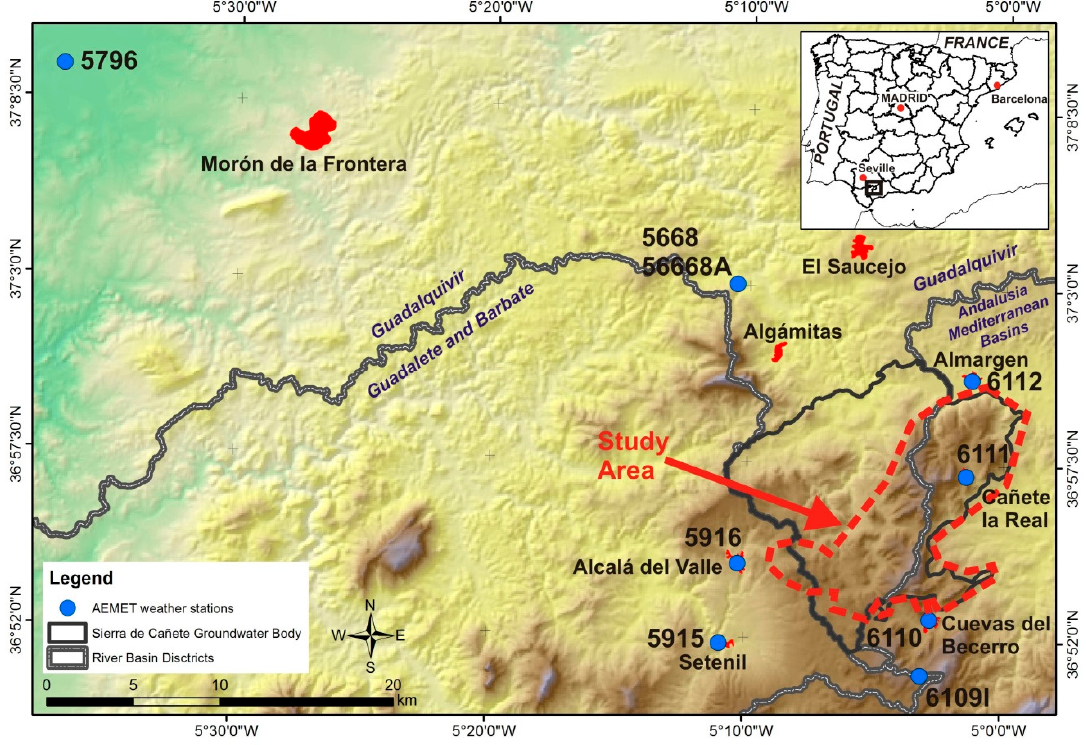
Figure 1. Geographical situation of the Sierra de Cañete aquifer.